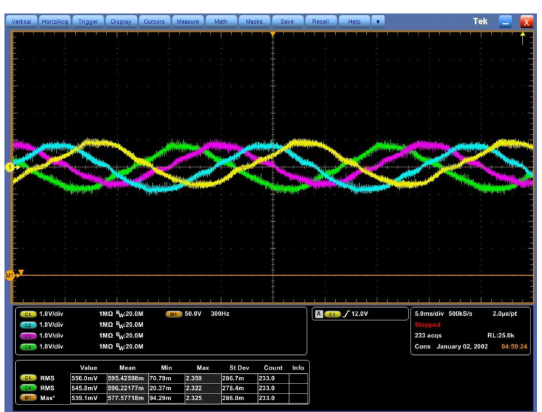
Figure 38. Measured motor phase currents in pentacle connection, no load